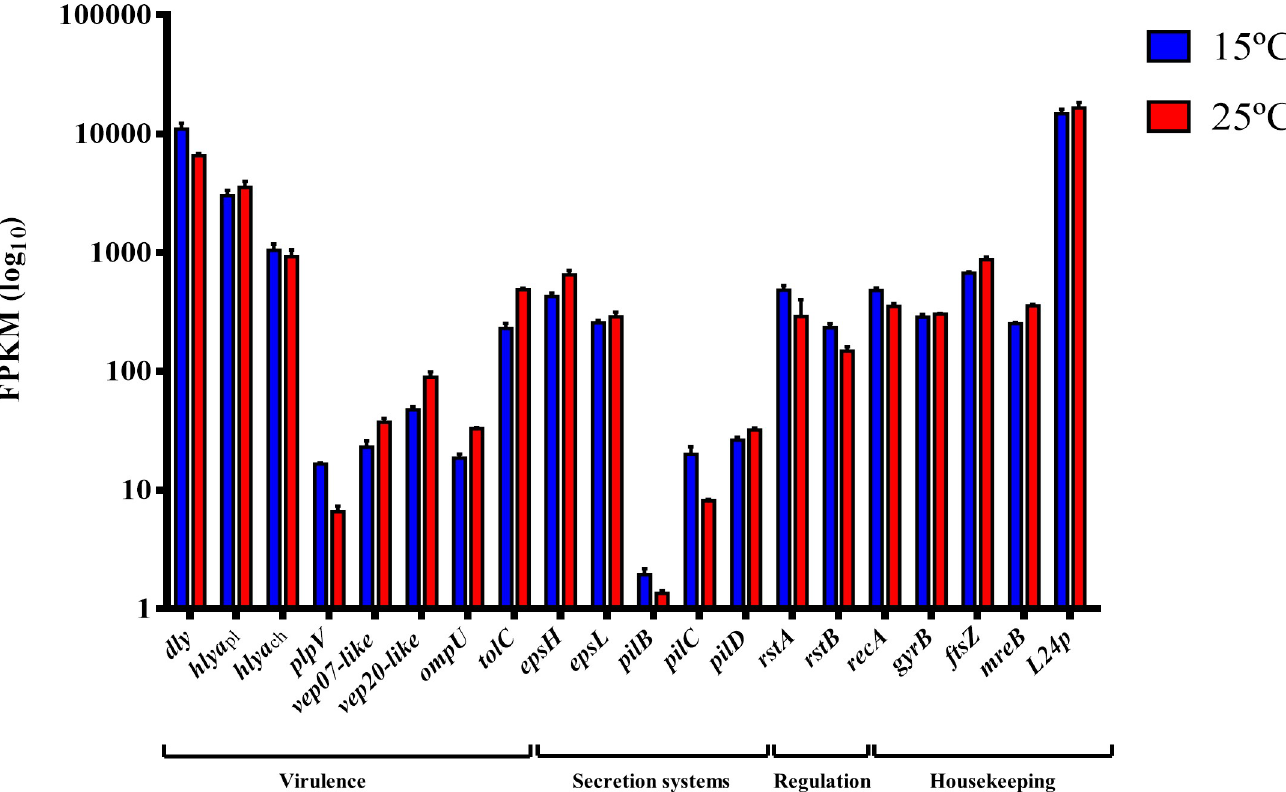
Fig 5. Damselysin toxin gene dly is one of the most highly expressed genes in Pdd . FPKM (Fragments Per Kilobase of transcript per Million mapped reads) values at the two assayed temperatures (S6 Table) were obtained for a selection of virulence and regulatory genes, secretion system genes and housekeeping genes including the top-expressed gene encoding ribosomal protein L24p, and compared using a logarithmic scale. Vertical error bars represent standard deviation of biological triplicates.